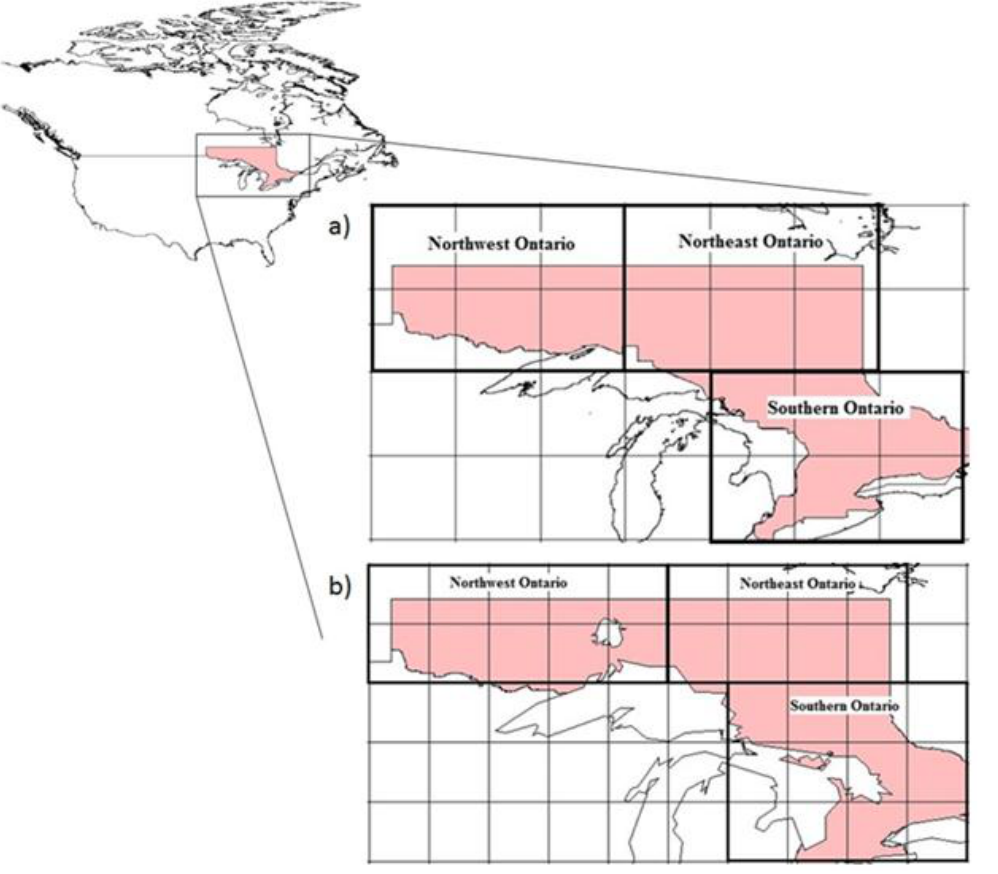
Figure 1. Location of study are in North America and the Province of Ontario in Canada. Grid sizes are based on the resolution of global climate model outputs for ( a ) CanESM2 and MIROC (~2.8°) and ( b ) MPI-ESM (~2.5°).